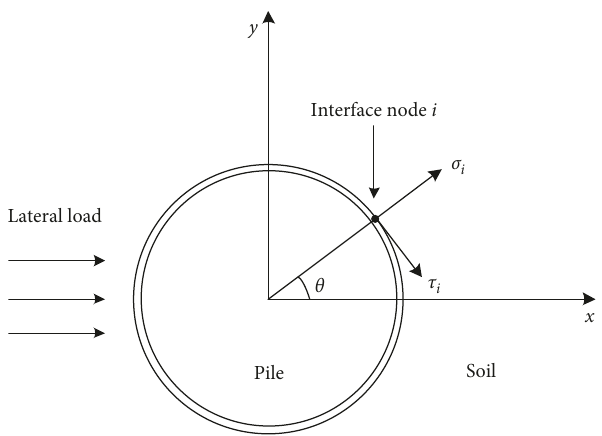
Figure 8: Normal stress and shear stress at the interface